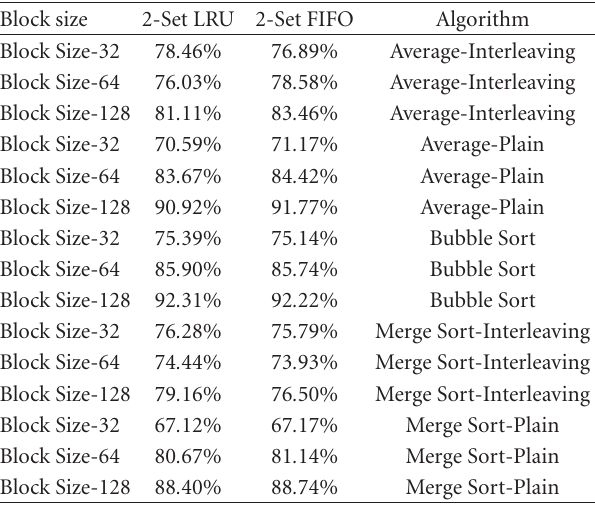
Figure 10: Hit ratio of replacement policy comparison—merge sort plain.